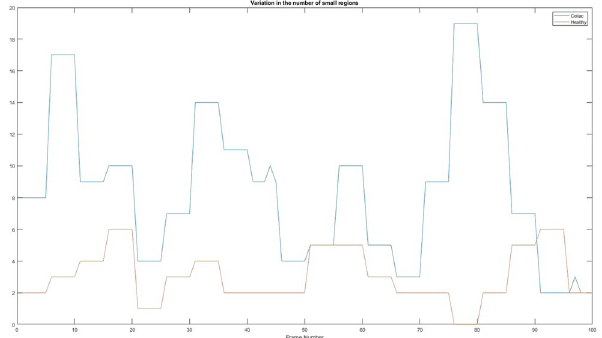
Figure 21. Variation in the number of small regions. Red = Healthy and Blue =